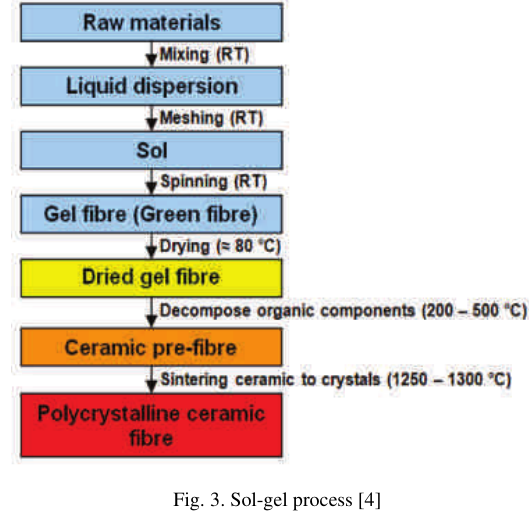
Fig. 3. Sol-gel process